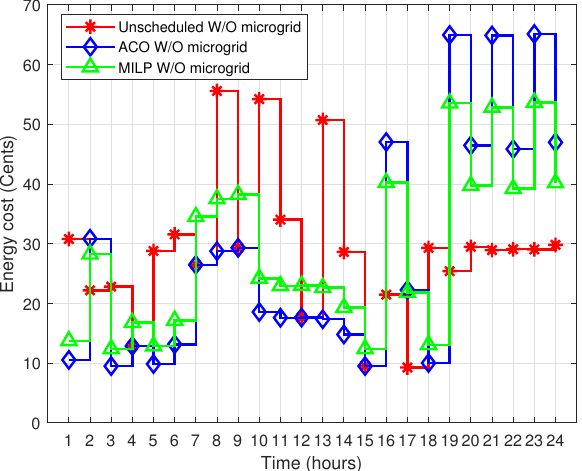
Figure 7. Energy cost evaluation W/O considering microgrid.